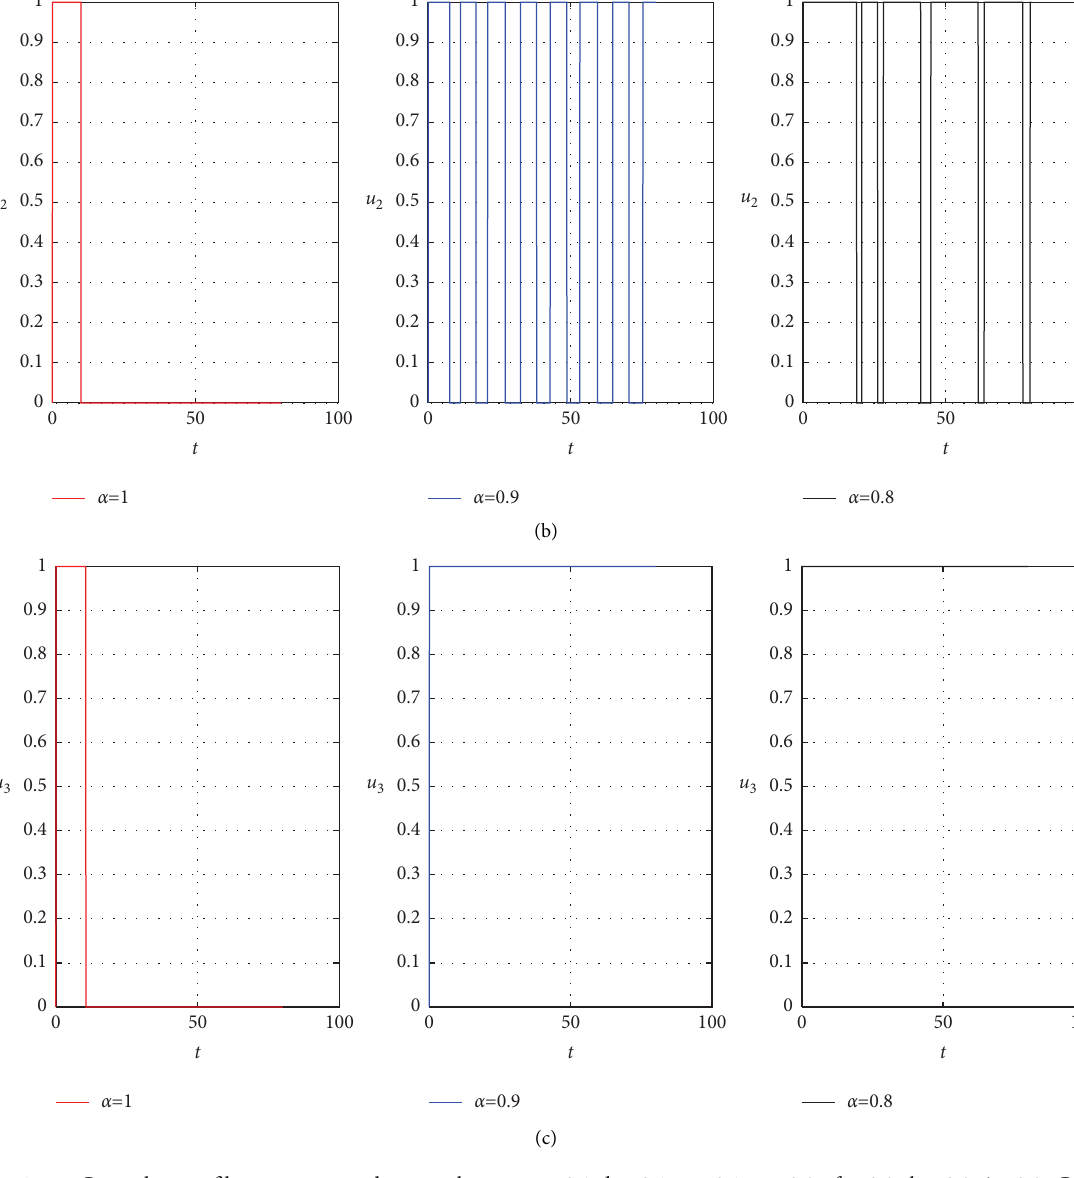
Control profles u � 0 . 0003 , A 3